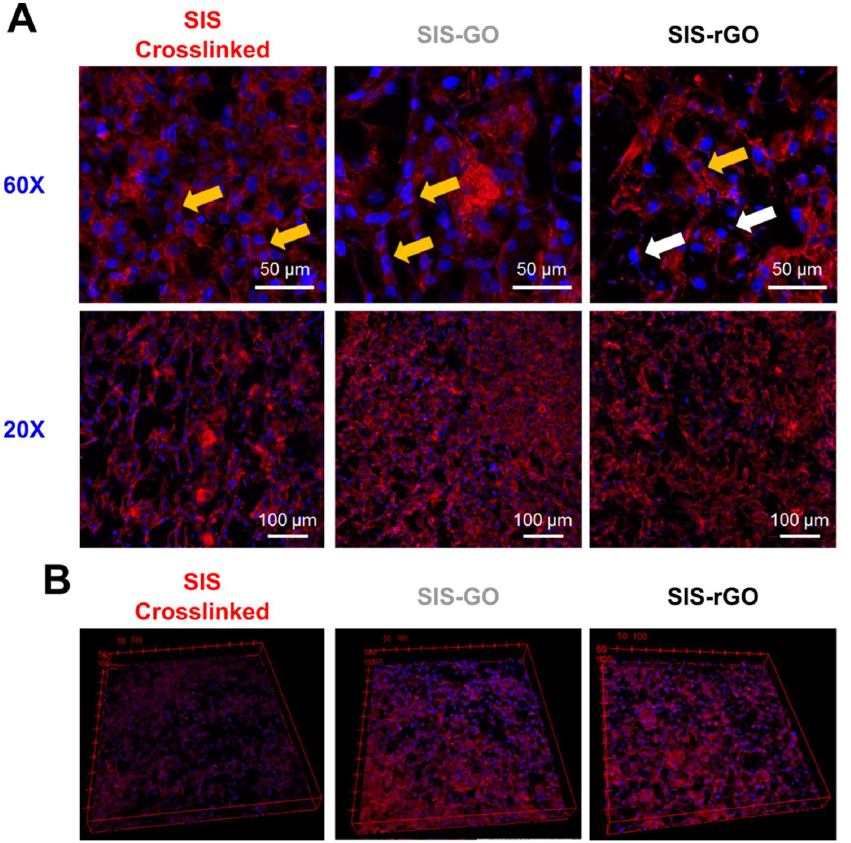
Figure 7. ( A ) Analysis of Vero cell morphology via confocal imaging. Yellow arrows present cells that exposed the typical elongated morphology confirming strong adhesion to the matrix, and white arrows expose cells with irregular round-shape morphology indicating poor adhesion to the matrix. ( B ) Three-dimensional reconstruction of cell distribution of Vero cells in all the developed scaffolds (confocal images 20×). Cell nuclei were stained with Hoechst 33342 (Blue) and actin filaments with Alexa Fluor 594 Phalloidin (Red).